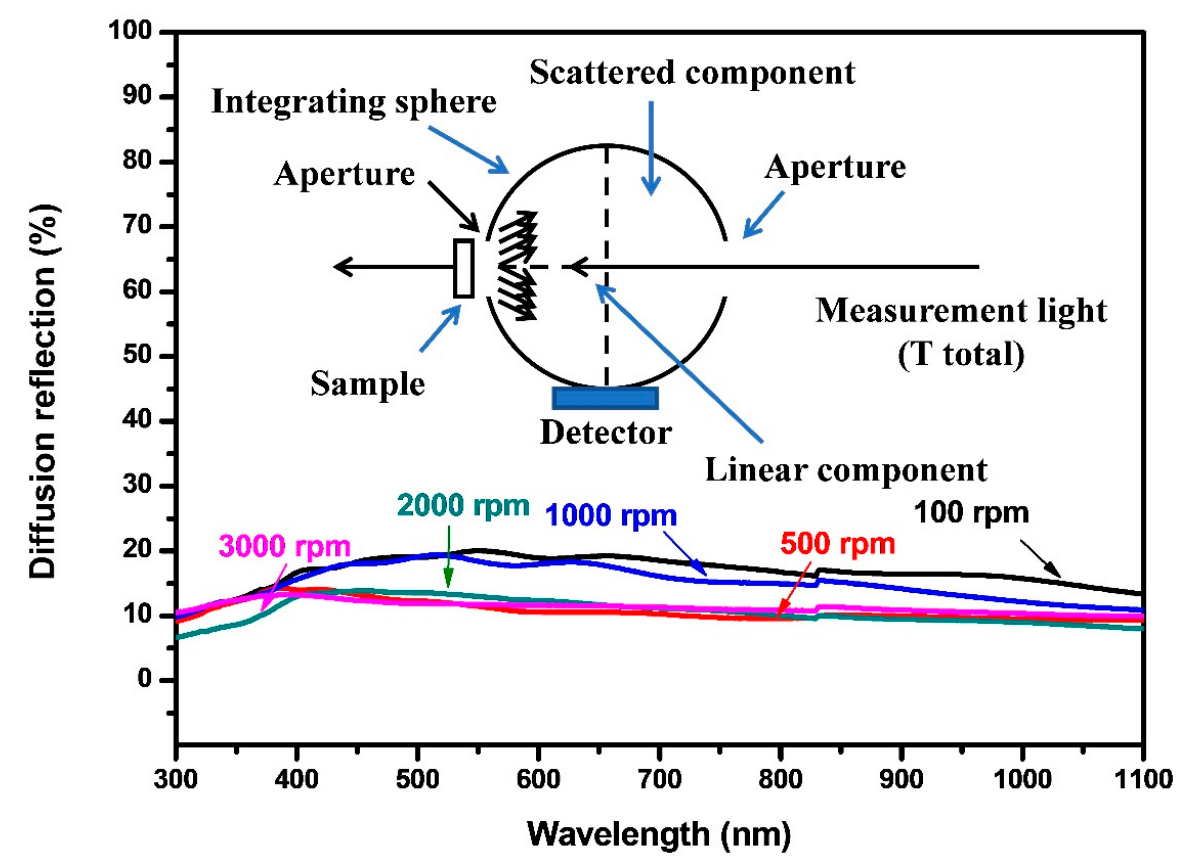
Figure 9. UV-Visible diffusion transmittance spectra of CuCrO 2 thin films prepared at different rotating speeds from 100 to 3000 rpm and annealed at 600 °C.